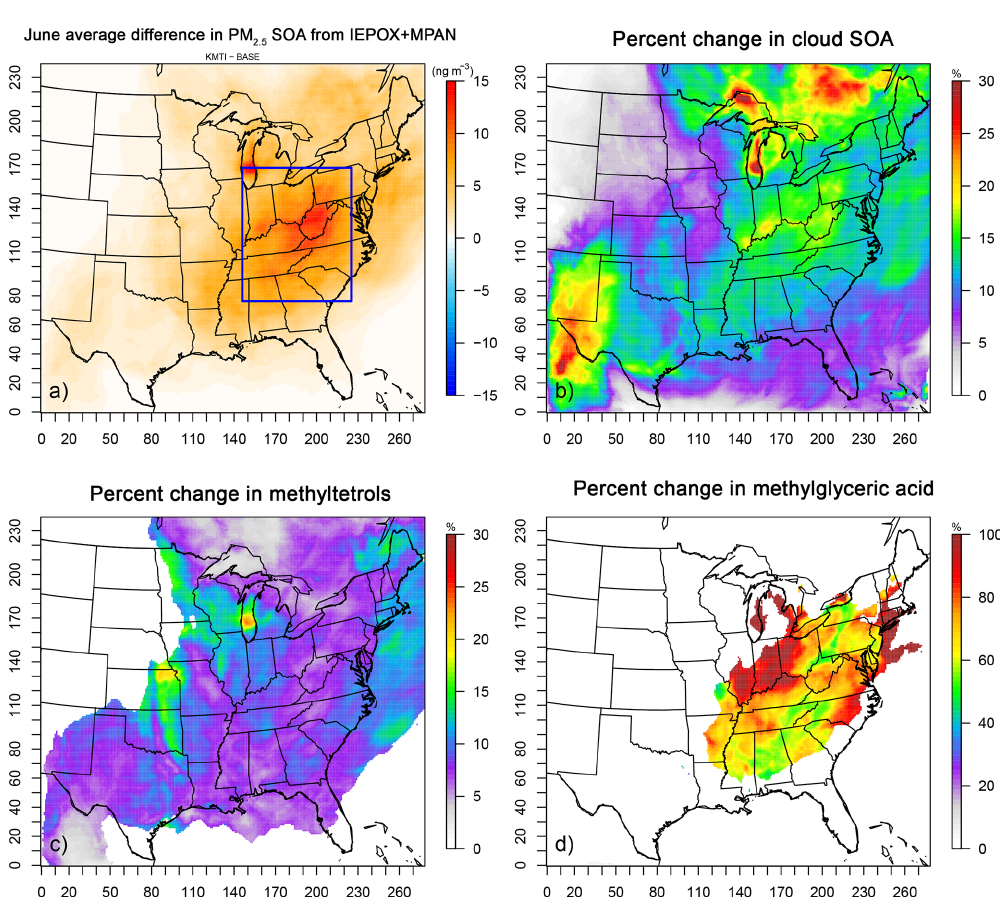
Figure 6. (a) June 2013 average increase in SOA from IEPOX/MPAN and percentage increase in surface-level (b) “cloud SOA” ( > 1ngm − 3 ) , (c) 2-methyltetrols ( > 10ngm − 3 ) , and (d) 2-MG ( > 1ngm − 3 ) . “SOA from IEPOX + MPAN” is the sum of 2-methyltetrols, 2-MG, and related organosulfates, organonitrates, and oligomers.